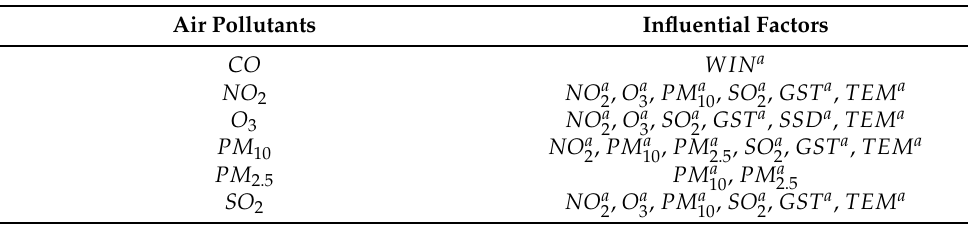
Table 5. The selected influential variables for every pollutant, where x a represent the air pollutant concentration the day in